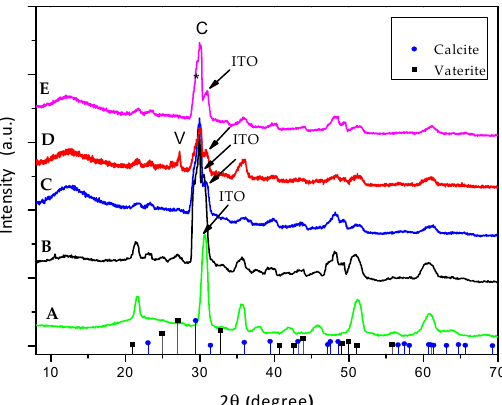
Figure 4. XRD pattern of ITO substrate ( A ) and CaCO 3 crystals obtained through EC in the presence on bare ITO as control ( B ), ALG Les modified ITO ( C ), ALG Les /MWCNT modified ITO ( D ), ALG Les /MWCNT-OX modified ITO ( E ), Vertical blue line and black line designation in graph indicate calcite and vaterite standard peaks, respectively. Meanwhile, designation C, V and * correspond to (104) face of calcite and ITO signal, respectively.